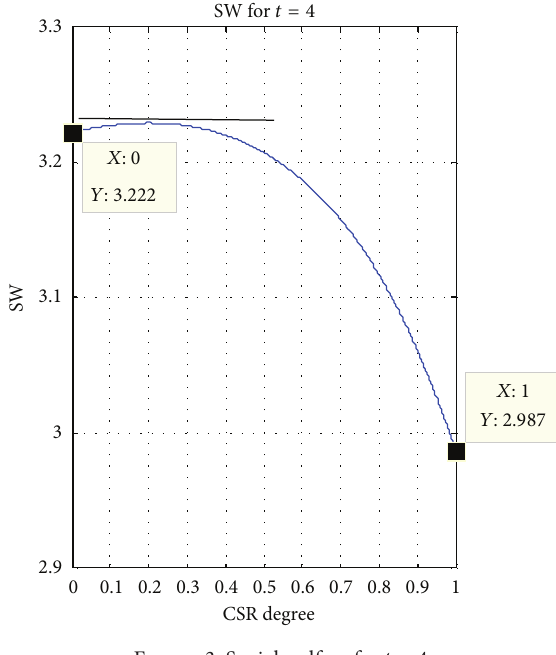
Figure 3: Social welfare for 𝑡 = 4 .